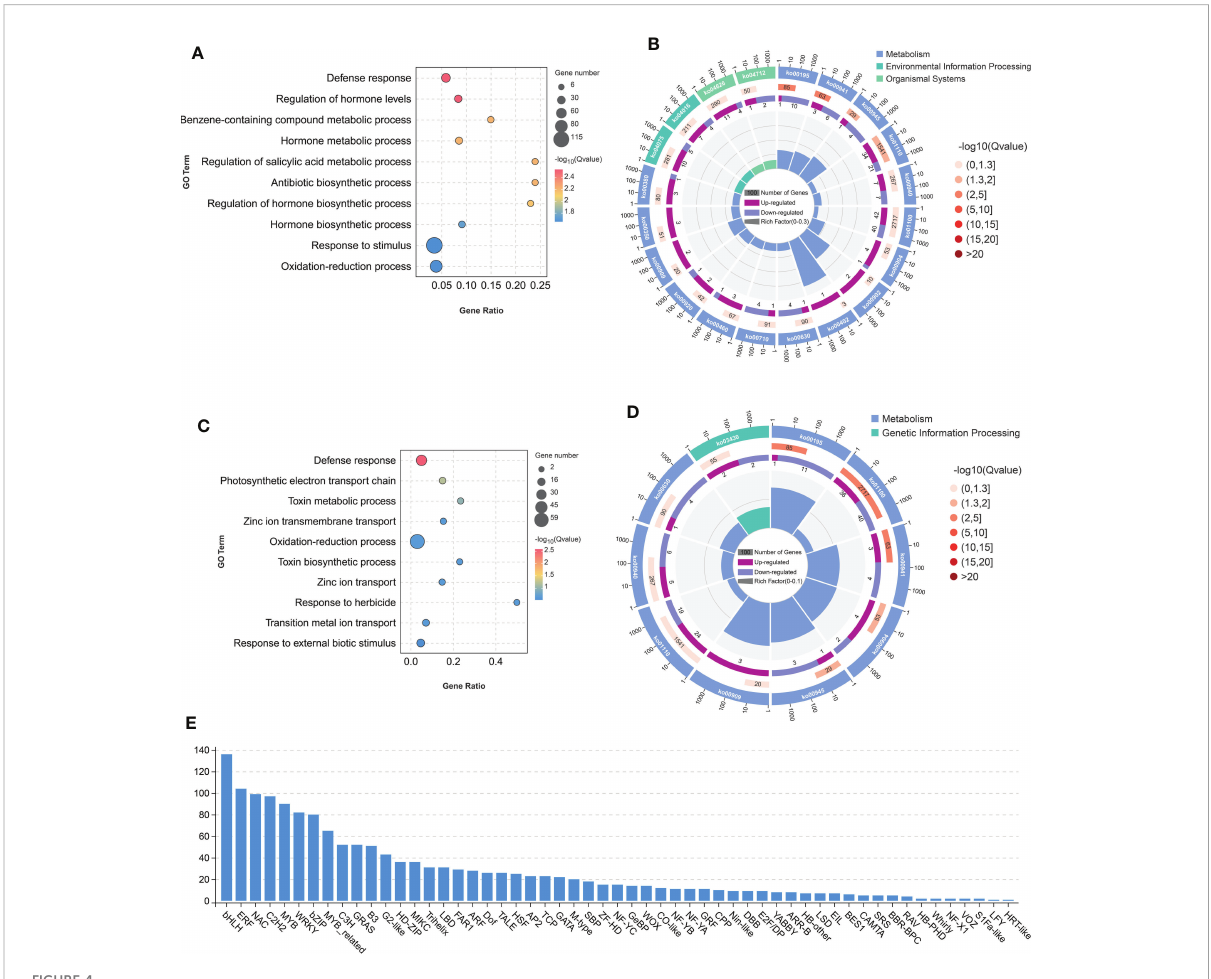
FIGURE 4 Differentially expressed genes (DEGs) between osseh1 lines and WT plants under normal condition and cold stress. (A) The Gene Ontology (GO) enrichment of DEGs between osseh1 lines and WT plants under normal condition. (B) The KEGG enrichment of the DEGs between osseh1 lines and WT plants under normal condition. (C) The Gene Ontology (GO) enrichment of DEGs between osseh1 lines and WT plants under cold stress. (D) The KEGG enrichment of the DEGs between osseh1 lines and WT plants under cold stress. (E) Transcription factor analysis on the DEGs between osseh1 lines and WT plants under cold